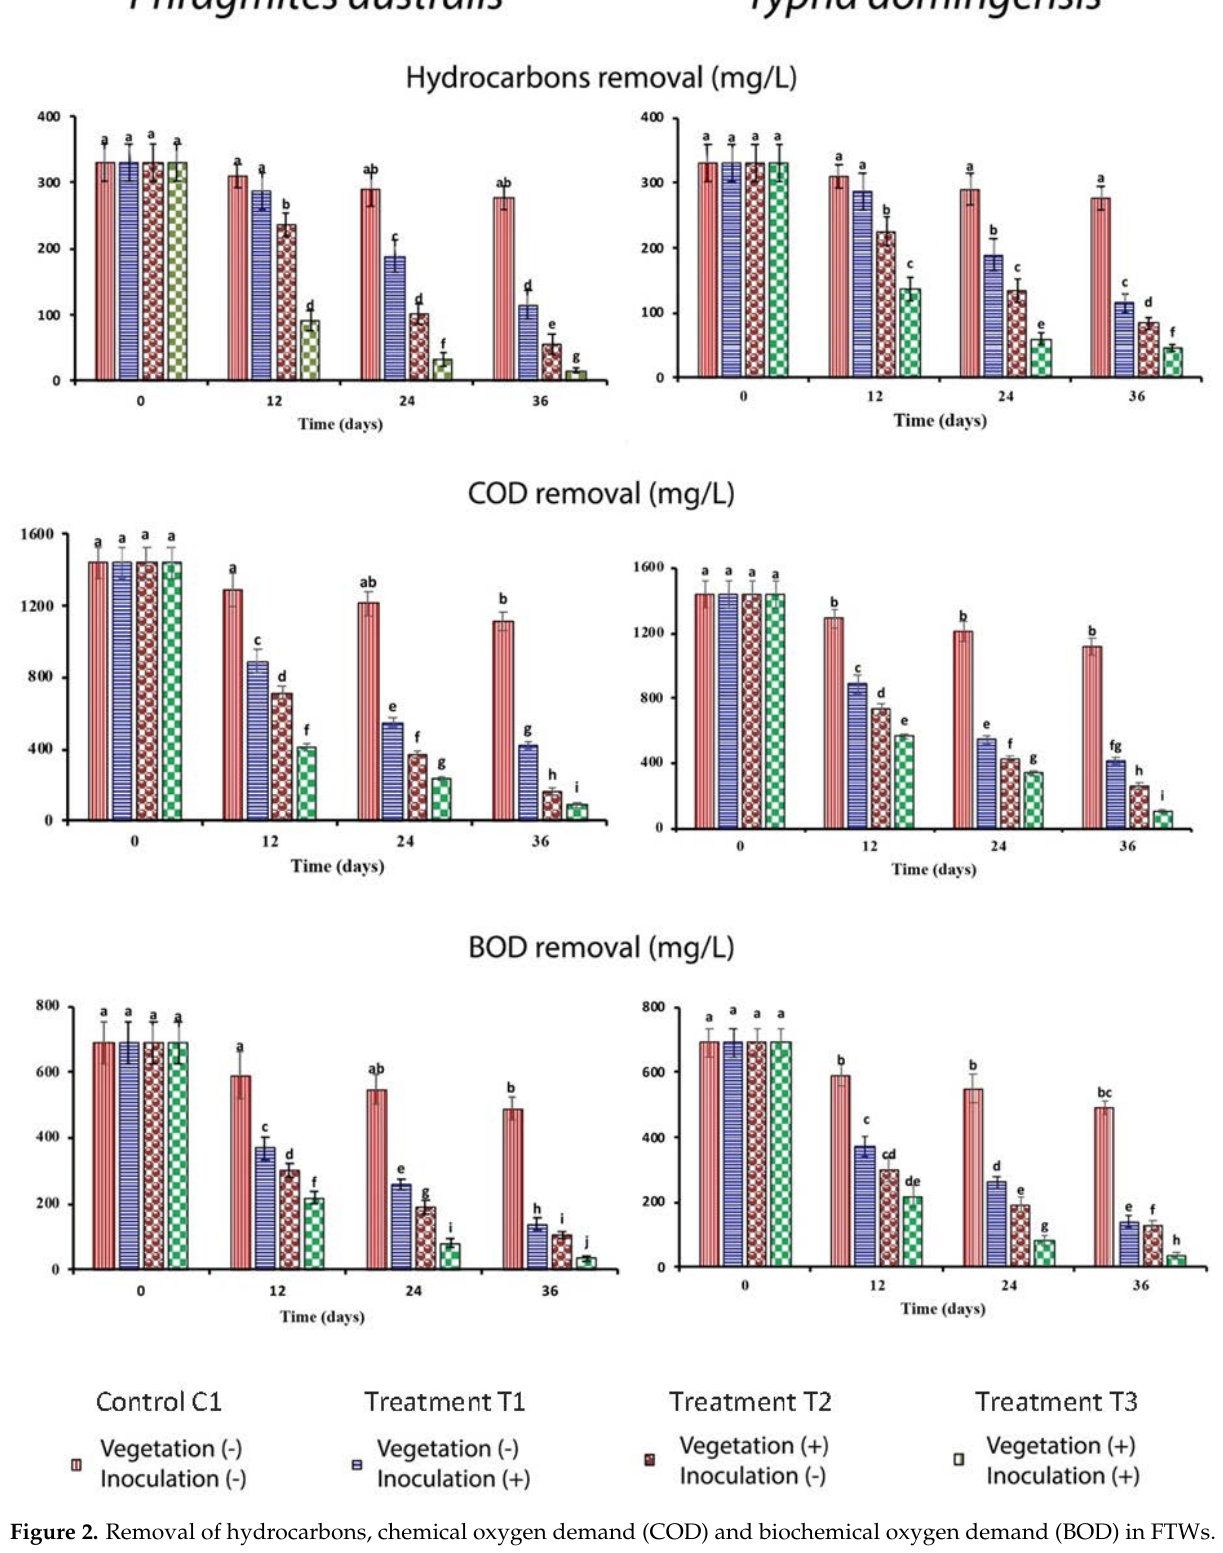
Figure 2. Removal of hydrocarbons, chemical oxygen demand (COD) and biochemical oxygen demand (BOD) in FTWs. The mean and standard error of three replicates is provided. The superscript letters behind the mean represent statistical comparison (ANOVA) per column. Same letters represent no differences and different letters represent statistical differences at 5% level of significance.